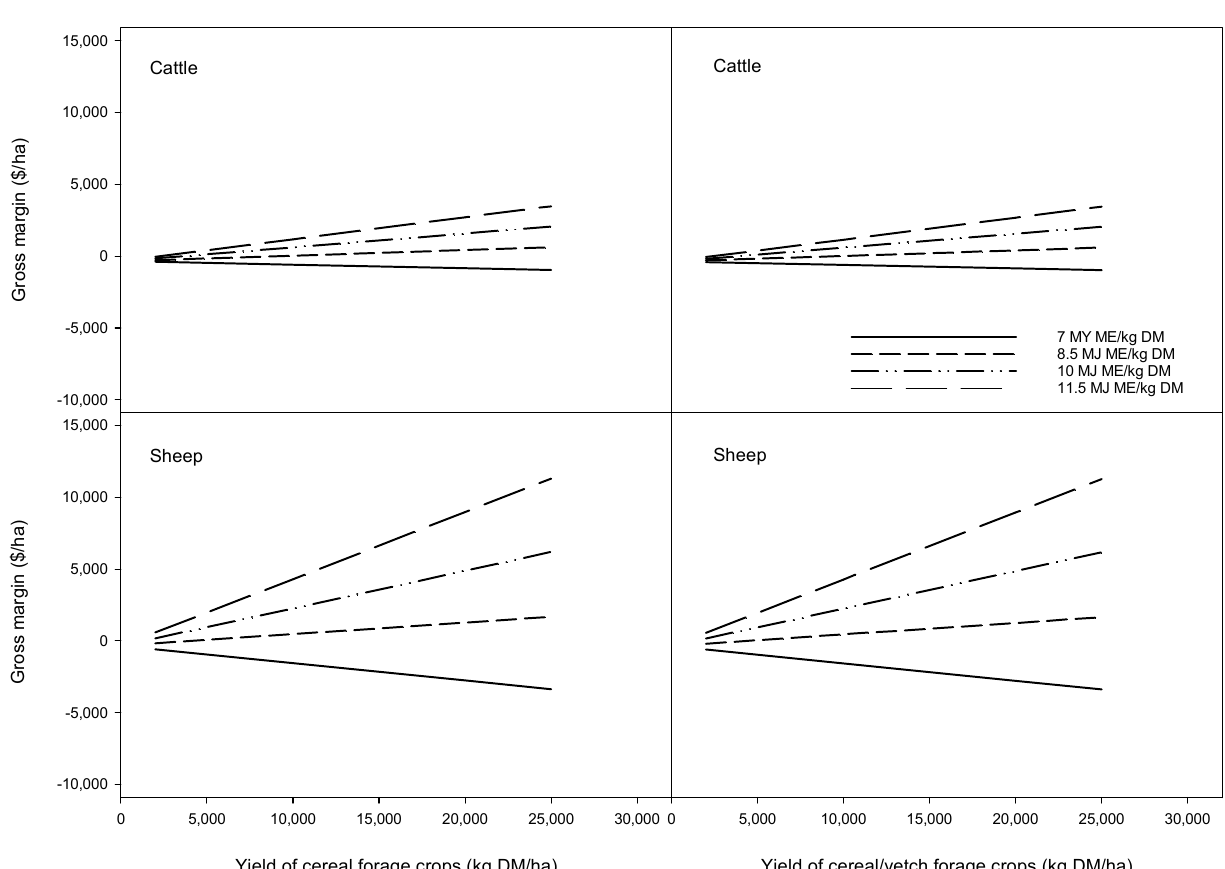
Figure 2. Relationship between yield and gross margin for cereal and cereal/vetch crops with different metabolisable energy (ME) content when fed to sheep and cattle. Crude protein content is assumed to be adequate.